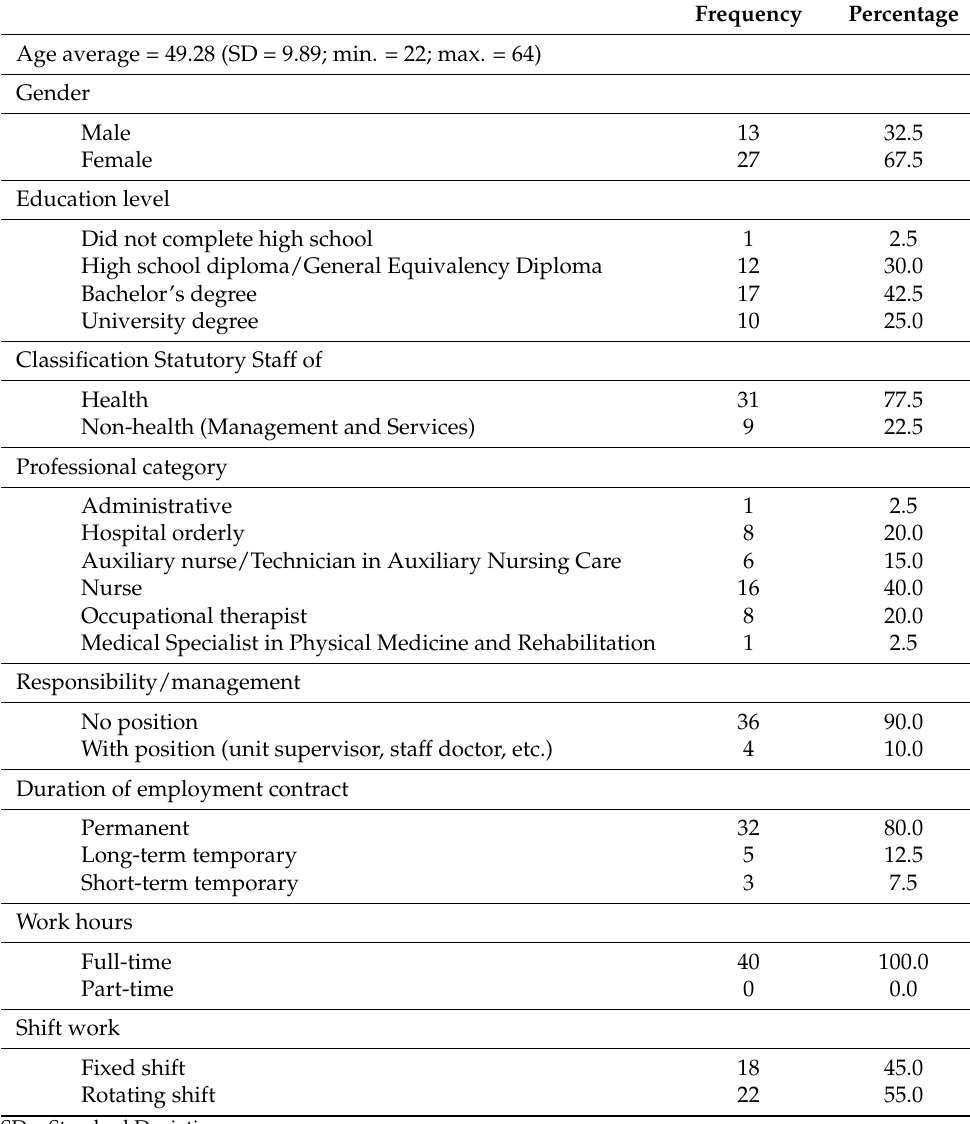
Table 1. Description of the respondent sample ( n =